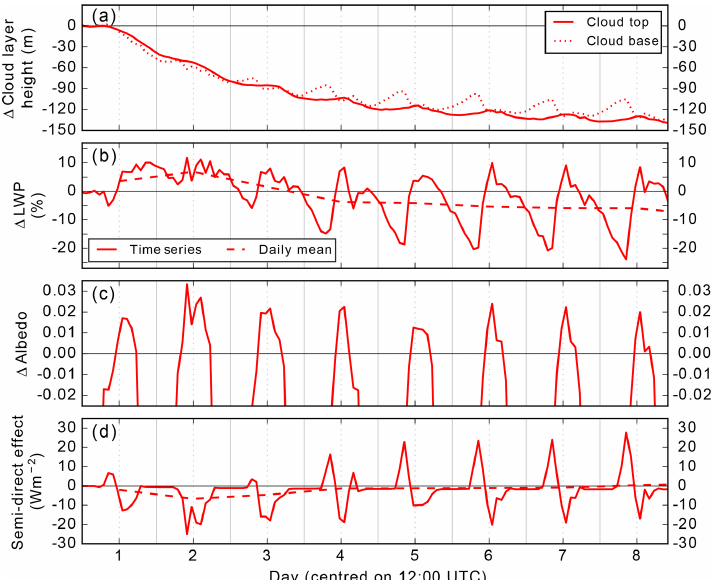
Figure 4. 10d time series of domain-averaged cloud response to a layer of aerosol directly above the boundary layer inversion with an aerosol optical depth of 0.2 and geometric thickness of 250m. Plots show the difference between the no-aerosol simulation and the simulation with an elevated aerosol layer for (a) cloud-top height (solid line) and cloud-base height (dotted line), (b) cloud liquid water path (LWP), (c) albedo, and (d) the semi-direct effect. Solid lines in (b) , (c) , and (d) show the time series of the response, and dashed lines in (b) and (d) show the daily